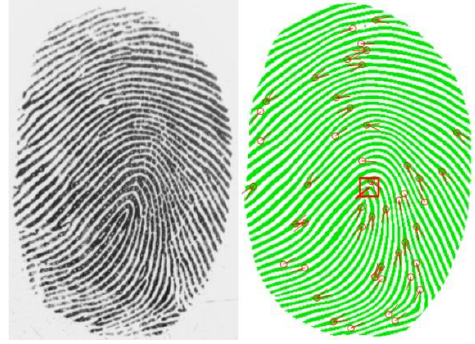
Fig. 2: Acquired and processed fingerprint